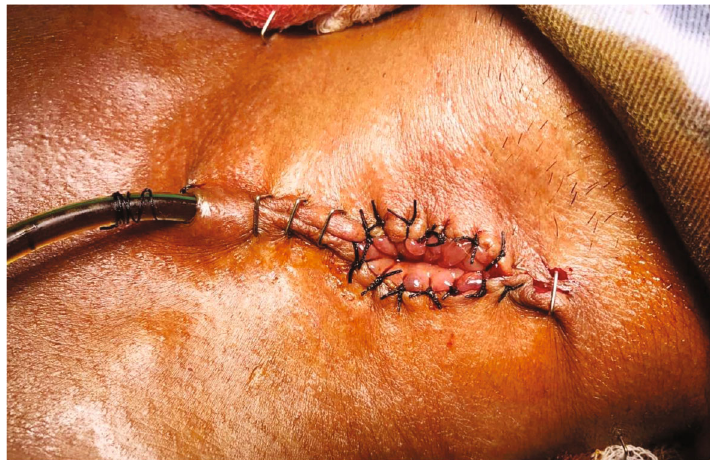
Figure 3: Exteriorized